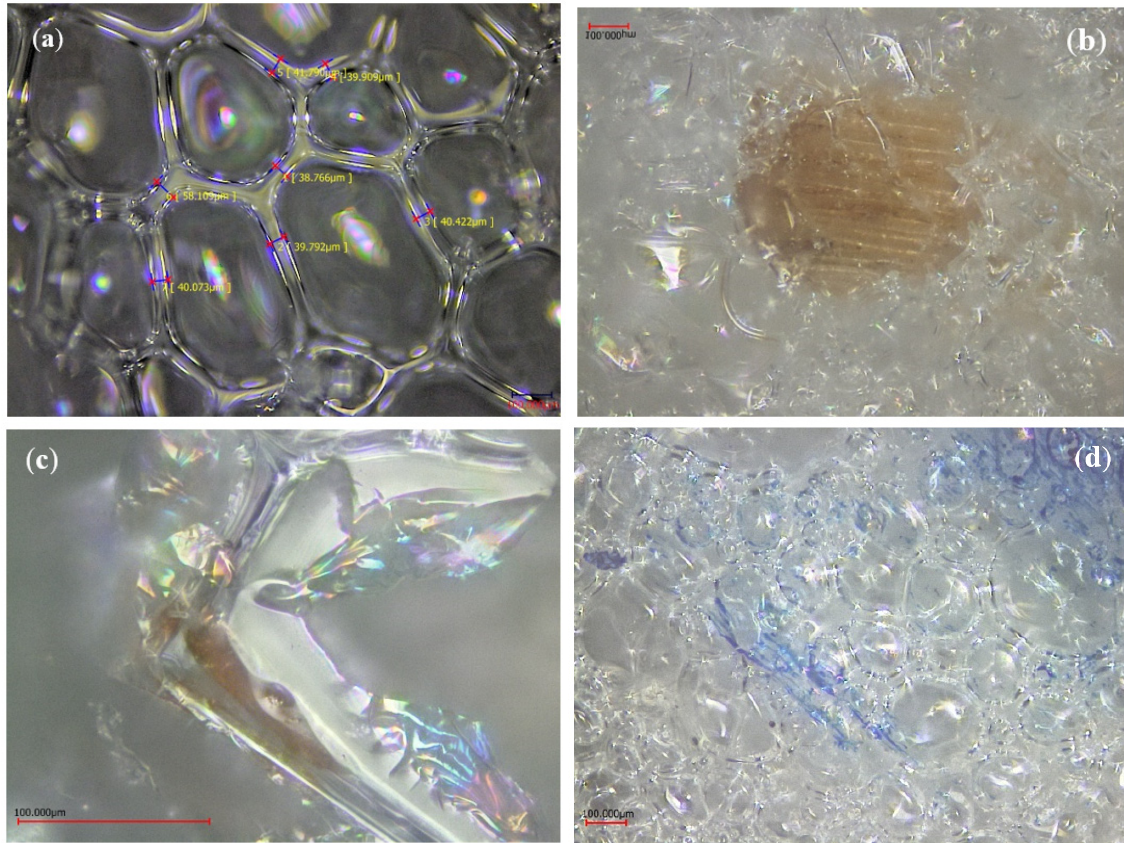
Figure 3. Cell morphology and fiber/matrix interaction: ( a ) Neat foam, ( b ) PUR-05, ( c , d ) PUR-01.